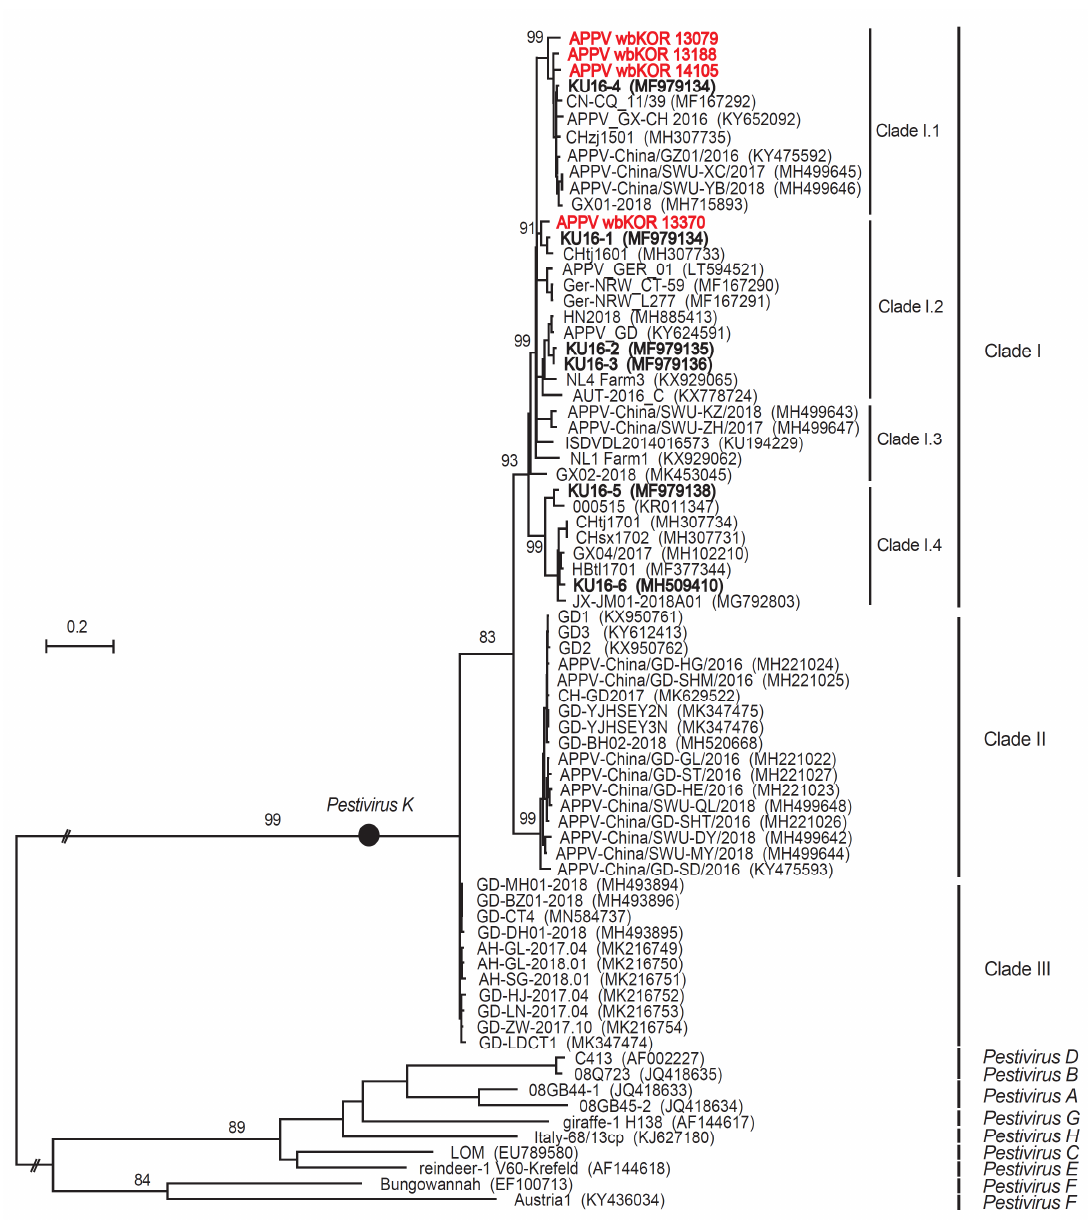
Figure 3. ML tree of South Korean wild boar APPVs, based on E2 sequences. The phylogenetic tree (Log L, − 11,438.12) was constructed using the ML method (based on the Tamura–Nei model), with bootstrap analysis ( n = 1000). The complete E2 sequences of four APPVs detected in South Korean wild boars were compared with 70 reference sequences (including ten outgroup strains: pestiviruses A–H).